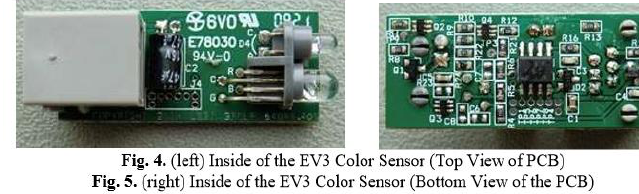
Sensor differentiates between 8 different colors i.e. Black, Blue, Green, Yellow, Red, White and Brown and No Color. The inside views of the color sensor are shown in Figure 4 and 5. On the top of the printed circuit board (PCB), the two LEDs are clearly visible in which the upper one having two pins is the photo detector while the bottom one is the LED having 4 pins, one for each color component (Red, Green and Blue) and a common cathode or anode. The processor used in the sensor is of